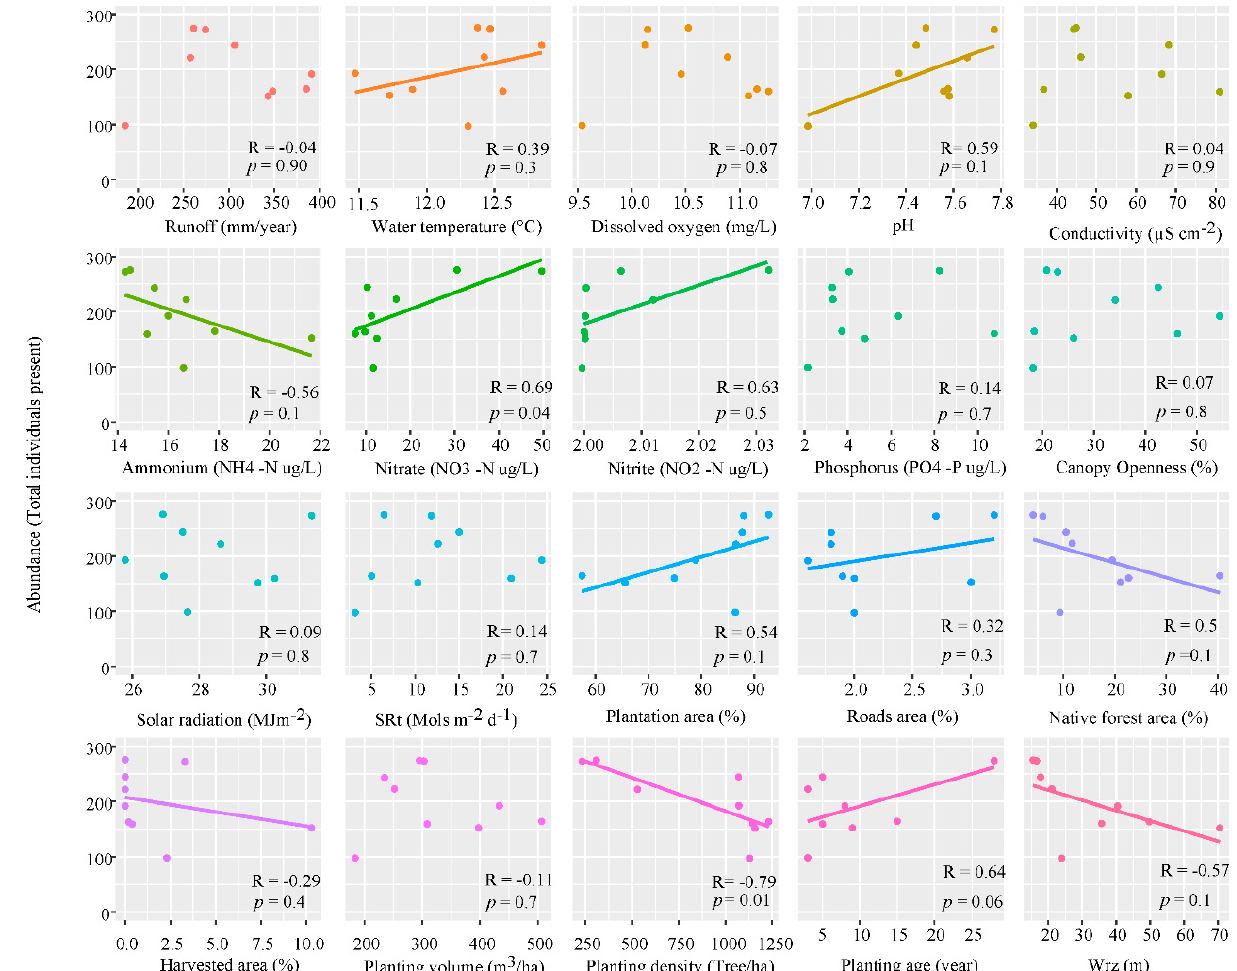
Figure 5. Linear regression of abundance, at the 9 sampling stations, against the physicochemical parameters; runoff (mm/year), water temperature (°C), dissolved oxygen (mg/L), pH, conductivity (µS cm − 2 ), ammonium (NH 4 -N µg/L), nitrate (NO 3 -N µg/L), nitrite (NO 2 -N µg/L), soluble phosphorus (PO 4 -P µg/L) solar radiation (MJm − 2 ) and solar radiation transmitted (SRt) (Mols m − 2 d − 1 ), and land cover data; canopy openness (%), plantation area (%), fractions of roads area (%), native forest area (%), harvested area (%), planting volume (m 3 /ha), plantation density (tree/ha), age plantation (year) and width riparian zone (Wrz) (m), p -value ≤ 0.05.